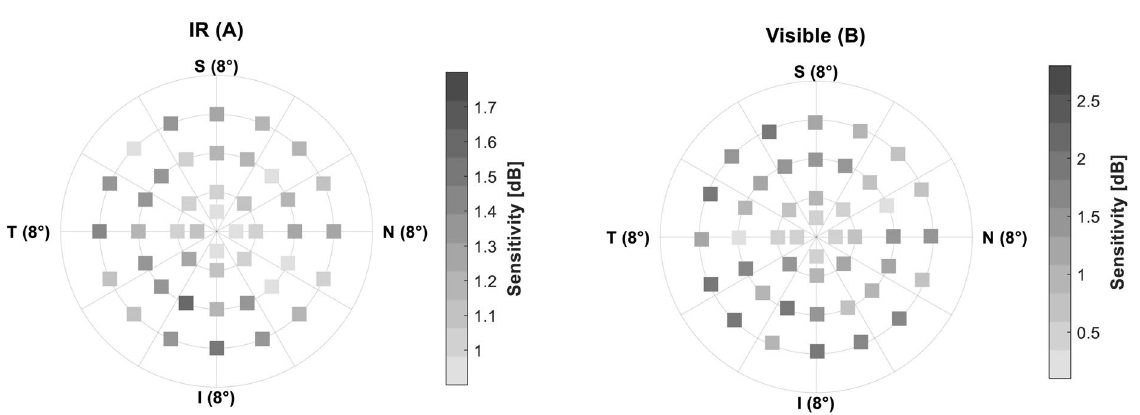
Figure 4. Grayscale-coded comparison of the absolute difference between IR ( A ) and visible ( B ) sensitivity. The color-coding was set according to the minimum and maximum values with a gradual change of gray shades by half of the standard